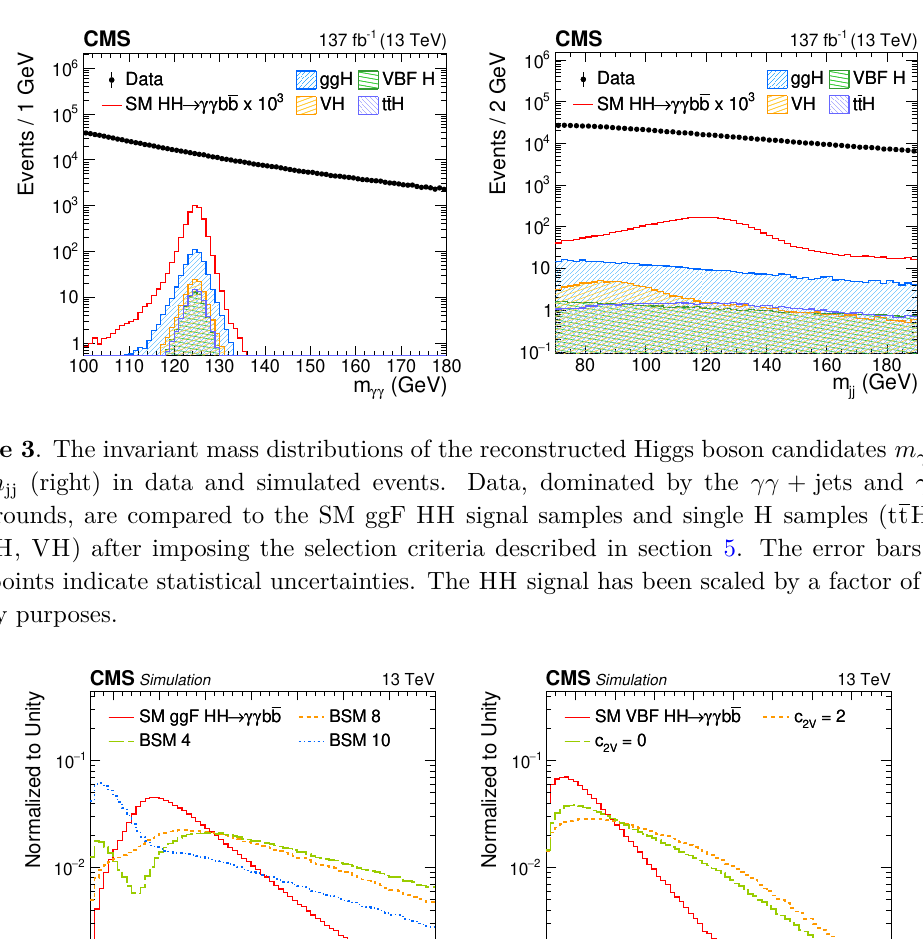
. The SM ggF HH signal is compared with several BSM hypotheses Figure 4 . Distributions of f M X listed in table 1 (left), and the SM VBF HH signal is compared with two different anomalous values of c (right). All distributions are normalized to 2V